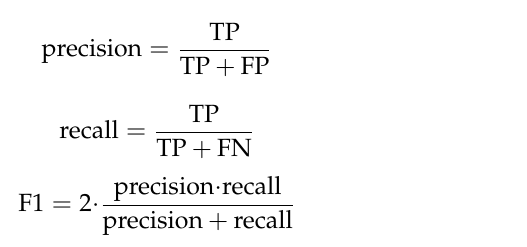
different distance thresholds.